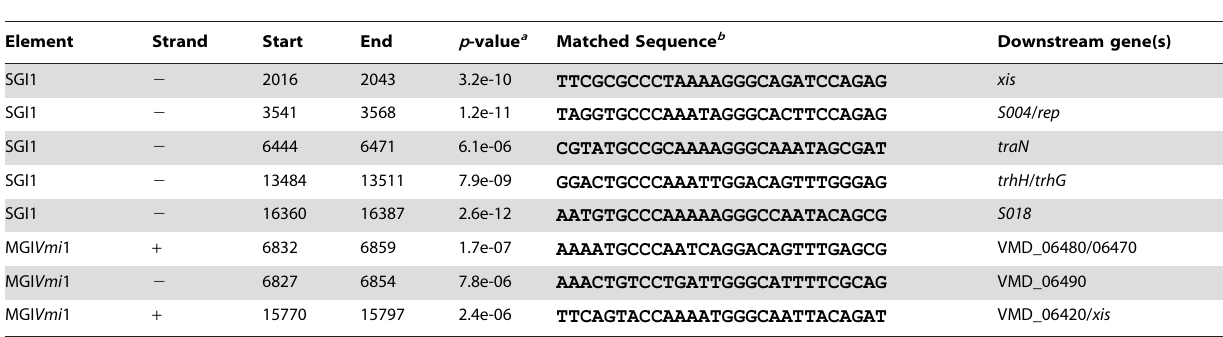
Table 1. Prediction of putative AcaCD-binding sites in SGI1 and MGI Vmi 1.